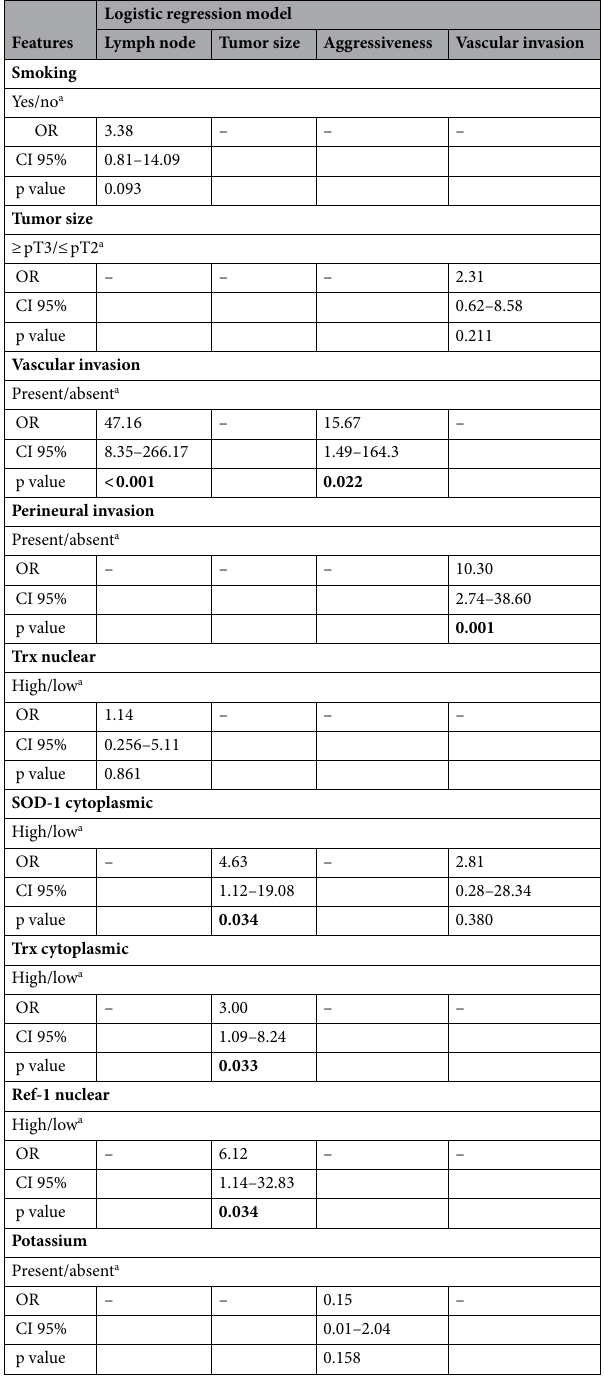
Table 2. Logistic regression model concerning lymph node, tumor size, aggressiveness and vascular invasion with epidemiological and clinicopathological characteristics, protein expression and trace elements. OR odds ratio, CI confidence interval. Values in bold represent p < 0.05. a Reference